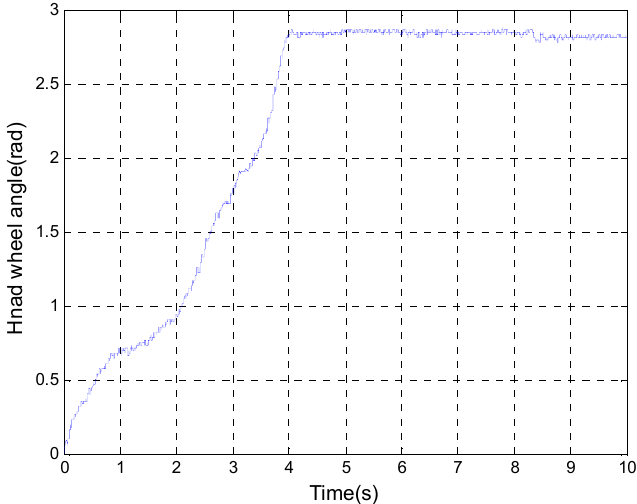
Figure 30. The steering wheel angle.